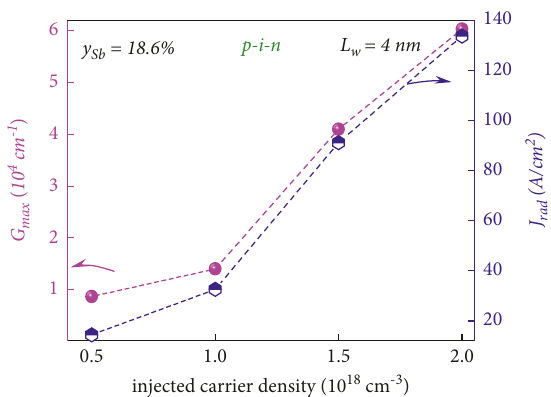
Figure 1: Band diagram of p-GaAs/i-GaN GaAs QW without and under an applied electric field F � 40kV/ cm.